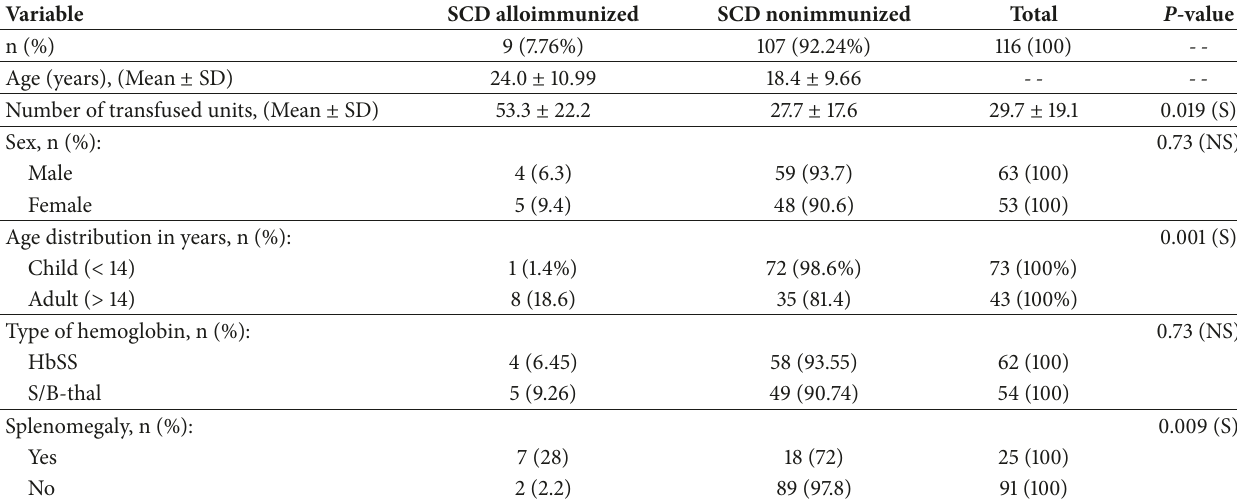
Table 1: SCD patients’ demographic and transfusion characteristics in Palestine.